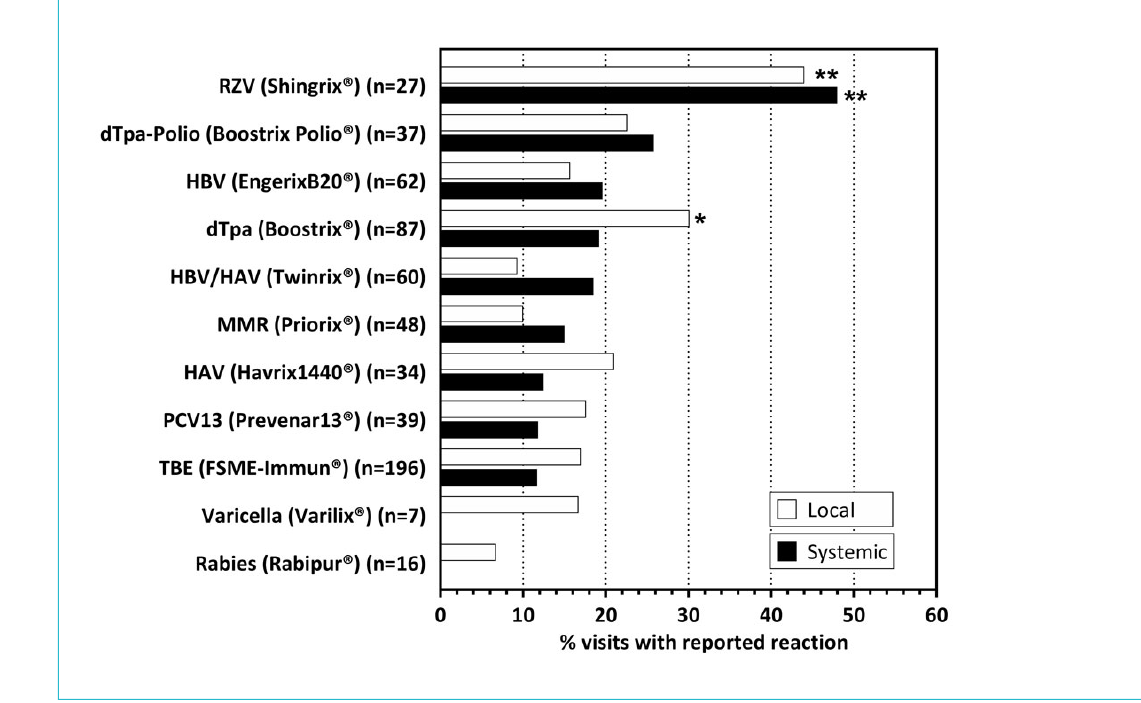
Figure 3: Frequency of local and systemic reactions by vaccine type. Data expressed as % of visits, with the administration of the respective vaccine that was associated with a local (white) or systemic (black) reaction. Subjects receiving the respective vaccine were compared with the rest of the cohort using Fisher’s exact test. *p <0.05; **p <0.001. RZV: recombinant zoster vaccine (Shingrix ® ); dTpa(-Polio): diphtheria- tetanus-pertussis (with/without poliomyelitis) vaccine: HBV: hepatitis B vaccine; HAV/HBV: combined hepatitis A and B vaccine; MMR: com- bined measles-mumps-rubella vaccine; HAV: hepatitis A vaccine; PCV13: pneumococcal conjugate vaccine; TBE: tick-borne encephalitis vac-